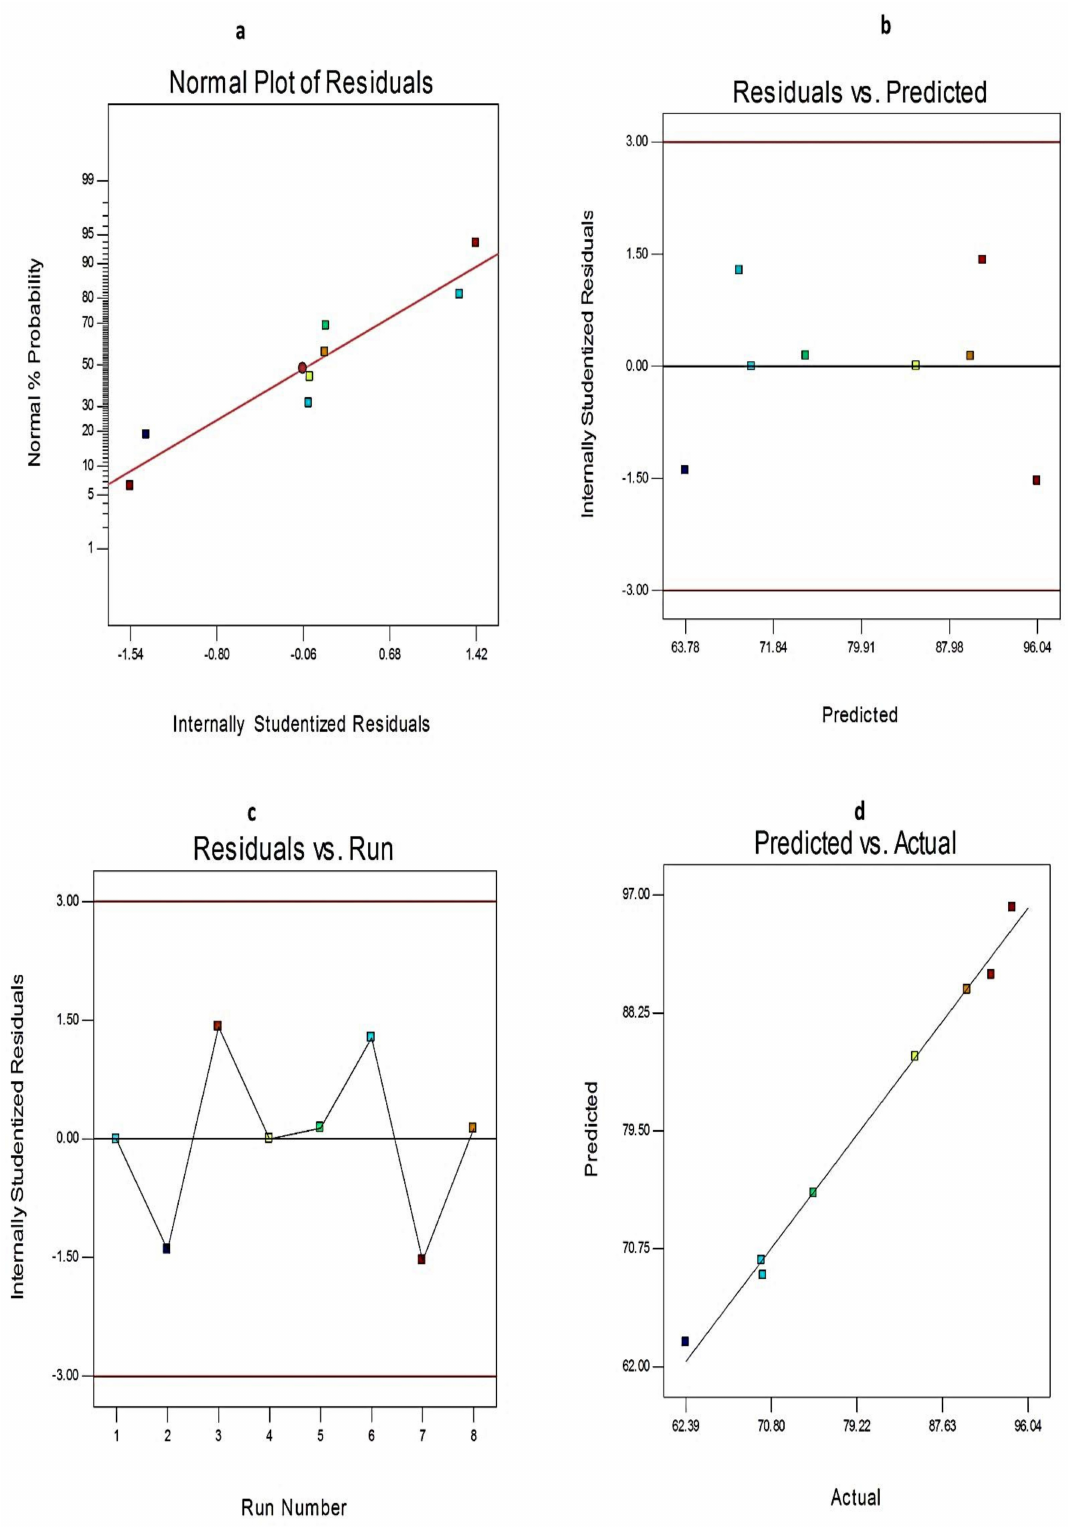
Figure 4. The diagnostic plots for Q 12h of EGCG-loaded spanlastics ( a ) plot of normal % probability versus the internally studentized residuals, ( b ) plot of the internally studentized residuals versus the predicted values, ( c ) plot of the internally studentized residuals versus the run number, and ( d ) plot of the predicted versus the actual values of Q 12h. Abbreviation: Q 12h , % EGCG released after 12